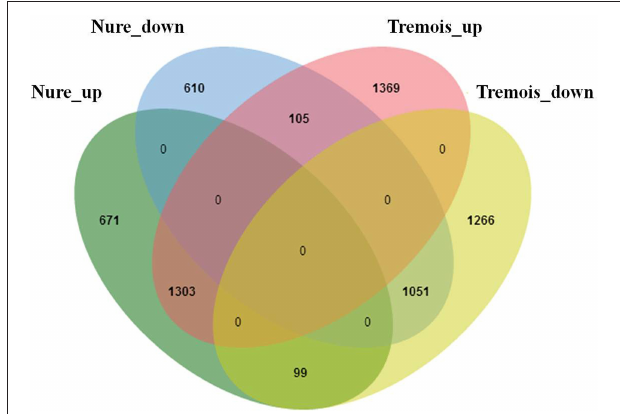
( PAPs ) increased, while one GPAT , one ethanolamine kinase